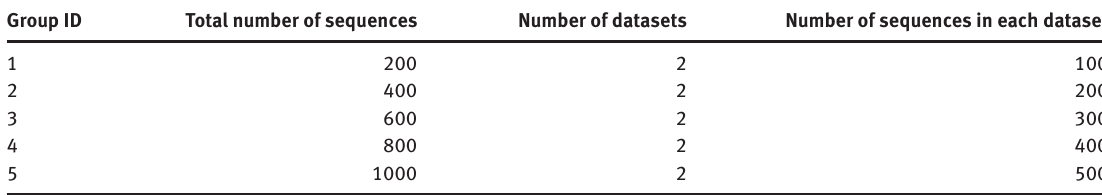
Table 6: Groups of Sequences